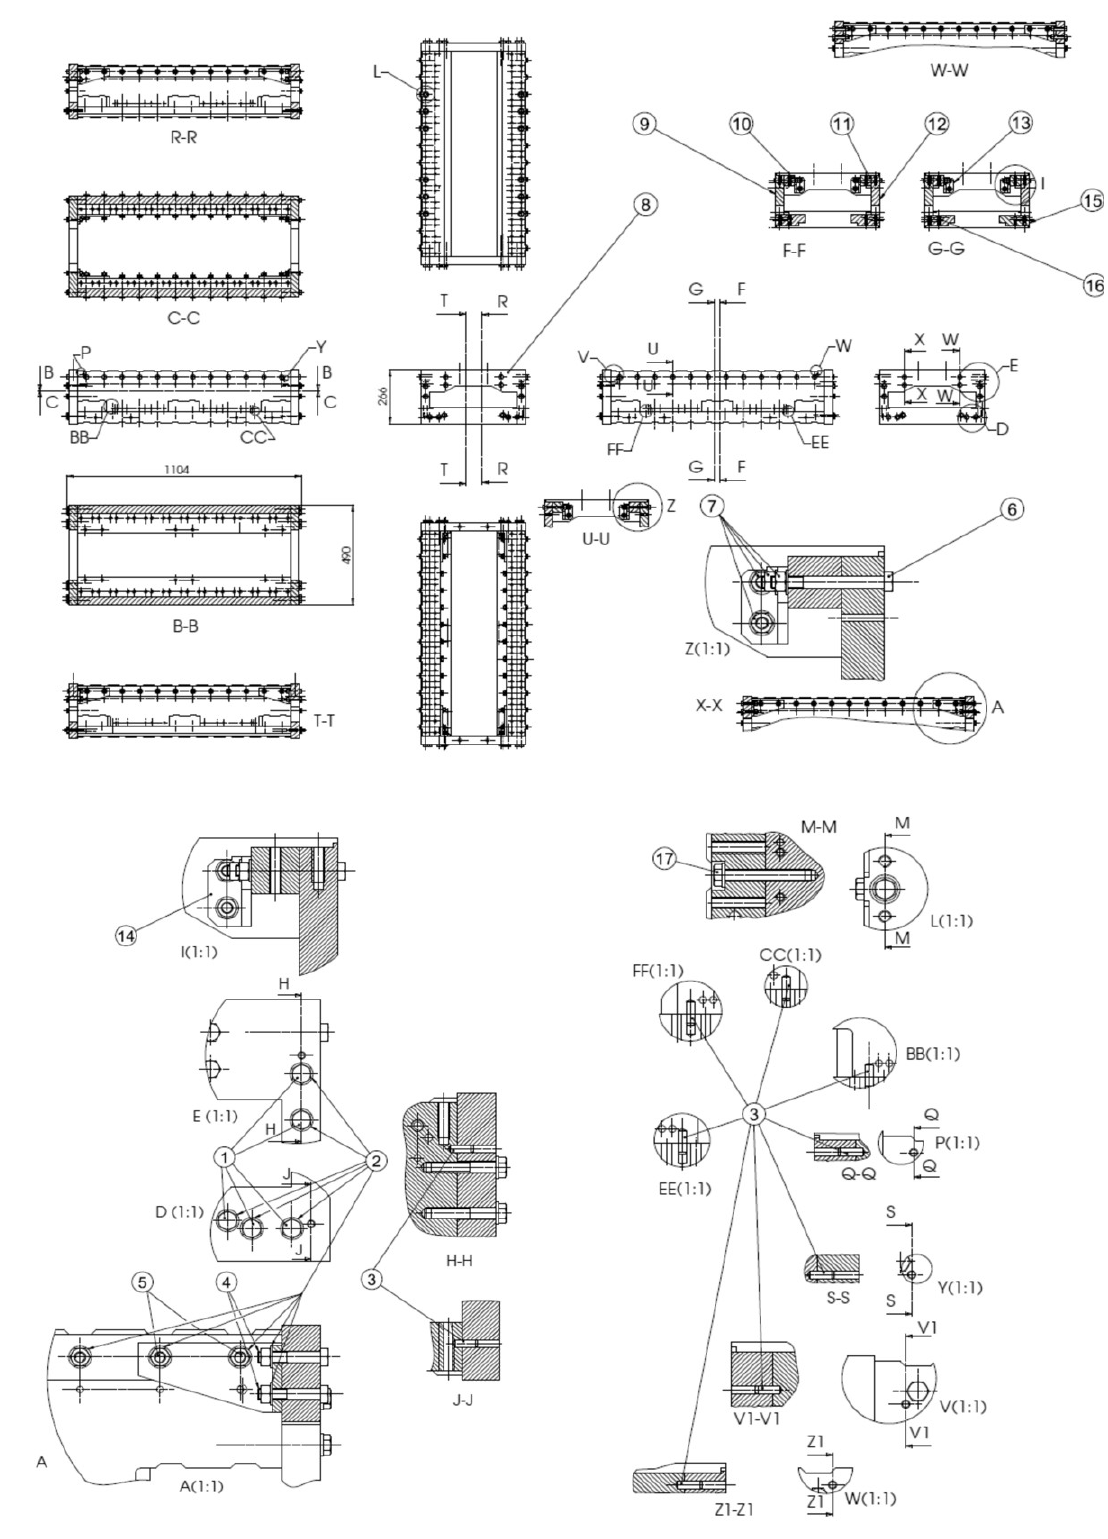
Figure 10: Technical drawing of the actuator frame manufactured in non-magnetic aluminum